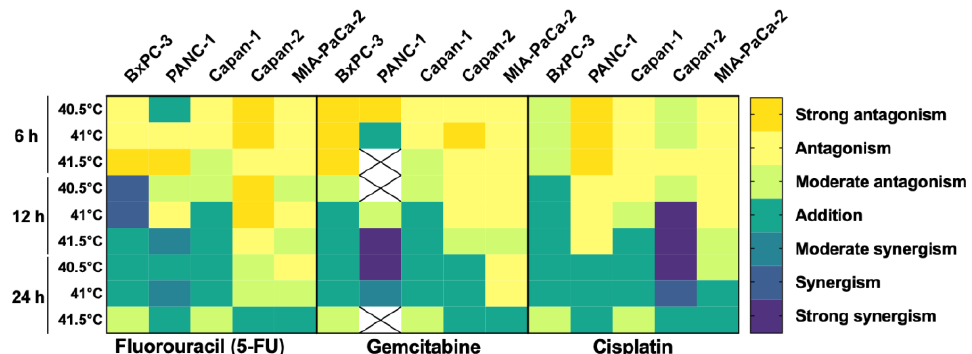
Figure 6. Hyperthermia and chemotherapeutics have additive/synergistic anticancer effects. Heatmap showing the combination index of hyperthermia and chemotherapy using different pancreatic cell lines and different temperatures and durations of hyperthermia. The combined effect between the two therapies is expressed as antagonistic, additive, or synergistic. Strong synergism: CI < 0.8; Synergism: 0.8 < CI > 0.85; Moderate synergism: 0.85 < CI > 0.9; Addition: 0.9 < CI > 1.1; Moderate antagonism: 1.1< CI >1.3; Antagonism 1.3< CI >1.8; Strong Antagonism CI > 1.9. X indicates data not available.